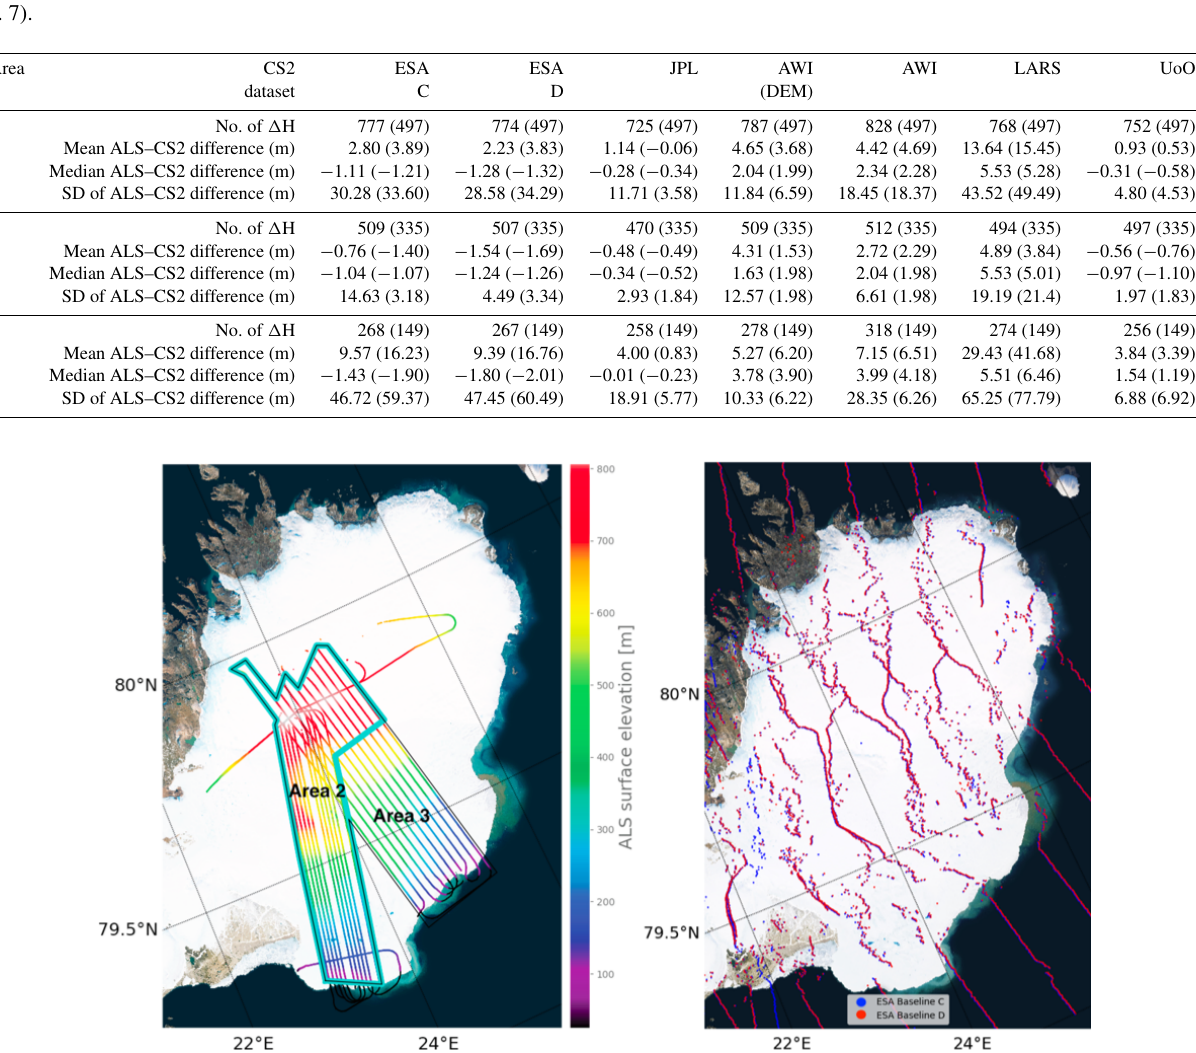
Figure 7. Left: the surface elevation measured by the CryoVEx airborne laser scanner (ALS). The thin black line outlines the entire study area (Area 1); the two subareas are indicated in the figure. Here, Area 3 is covering the complex surface topography of the surging basin of the Austfonna ice sheet. Right: the geolocations of the two ESA L2 baselines. Map data ©2019